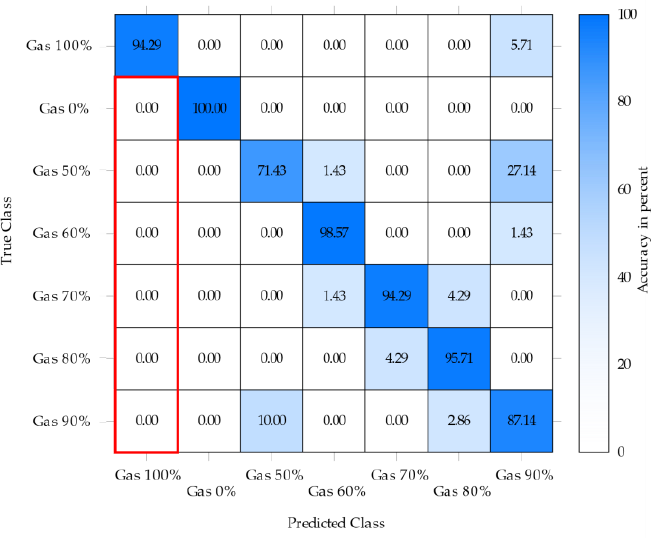
Figure 11. Confusion matrix for the prediction of shielding gas flow rates with the mean accuracy after 10-fold cross-validation. Type I errors are shown in the red rectangle.